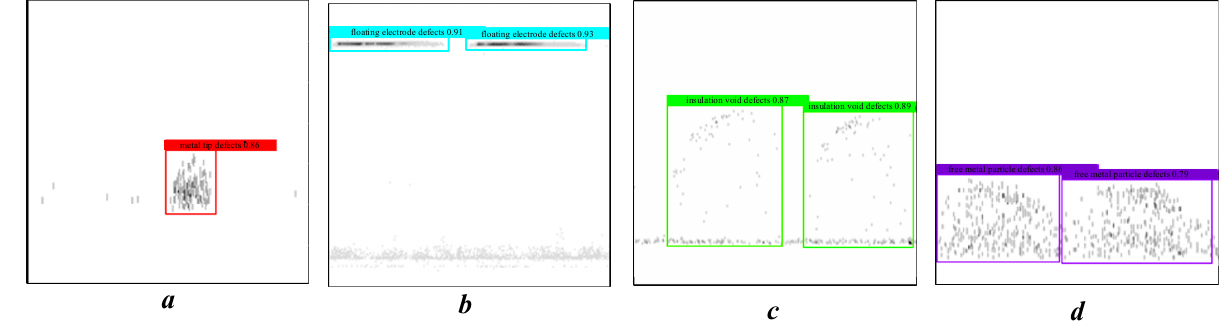
Figure 11. Result of PD defects detection. ( a ) metal tip defects, ( b ) floating electrode defects, ( c ) insulating void defects, ( d ) free metal particle defects.